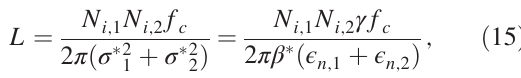
emittance is much larger than the Au beam ’ s.